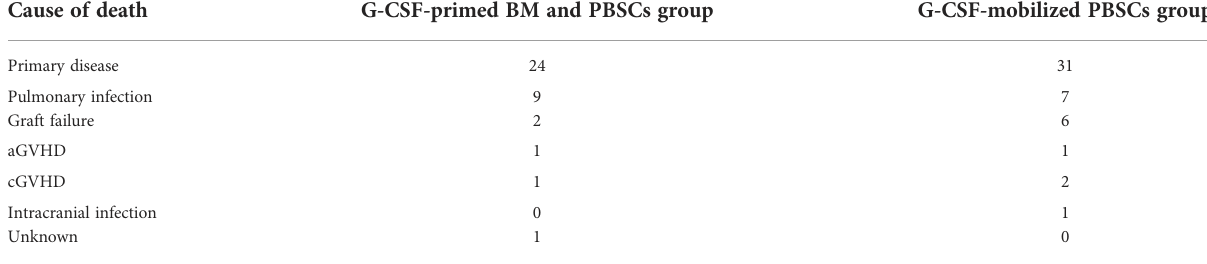
TABLE 2 Cause of death after haplo-HSCT in patients who received G-CSF-primed BM and PBSCs mixture or G-CSF-mobilized PBSCs graft. Cause of death G-CSF-primed BM and PBSCs group